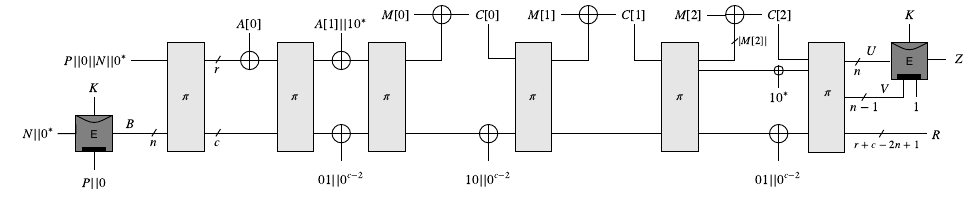
Figure 1: TETsponge mode with TBC E and permutation π , applied to a 2-block A and a 3-block M . The value 01 || 0 c − 2 is inserted only if | A [ λ − 1] | < r (resp., | M [ ‘ − 1] | < r